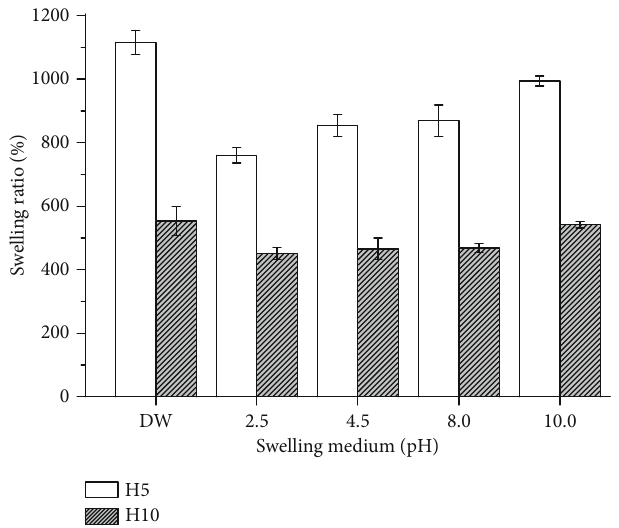
Figure 3: E ff ect of di ff erent media and pH on hydrogel swelling capacity (%) after 24 h of swelling.